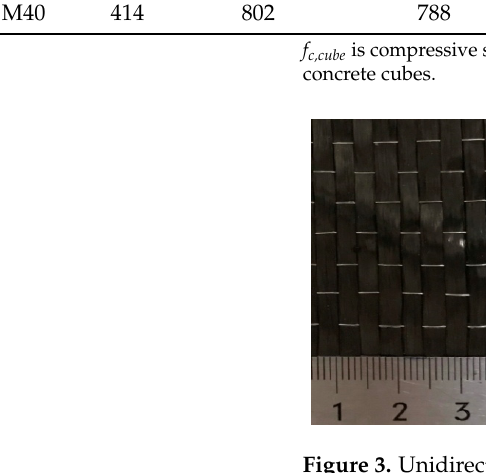
Table 2. Mechanical properties of adhesive, CFRP sheets, and steel reinforcement.